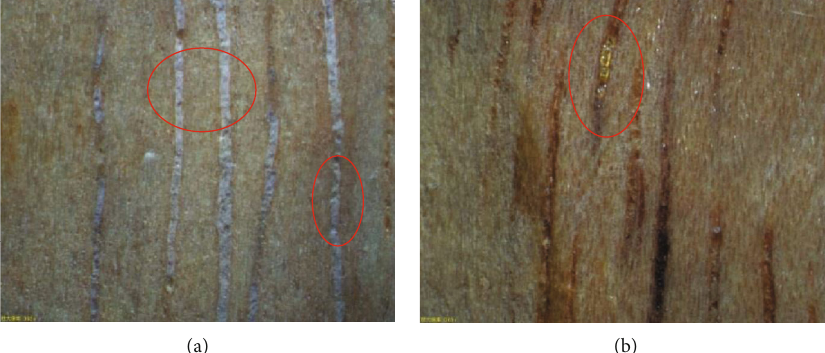
Figure 7: Photomicrographs of control and 25% MUG resin-treated wood at the radial section. (a, b) Control and 25% MUG resin-treated